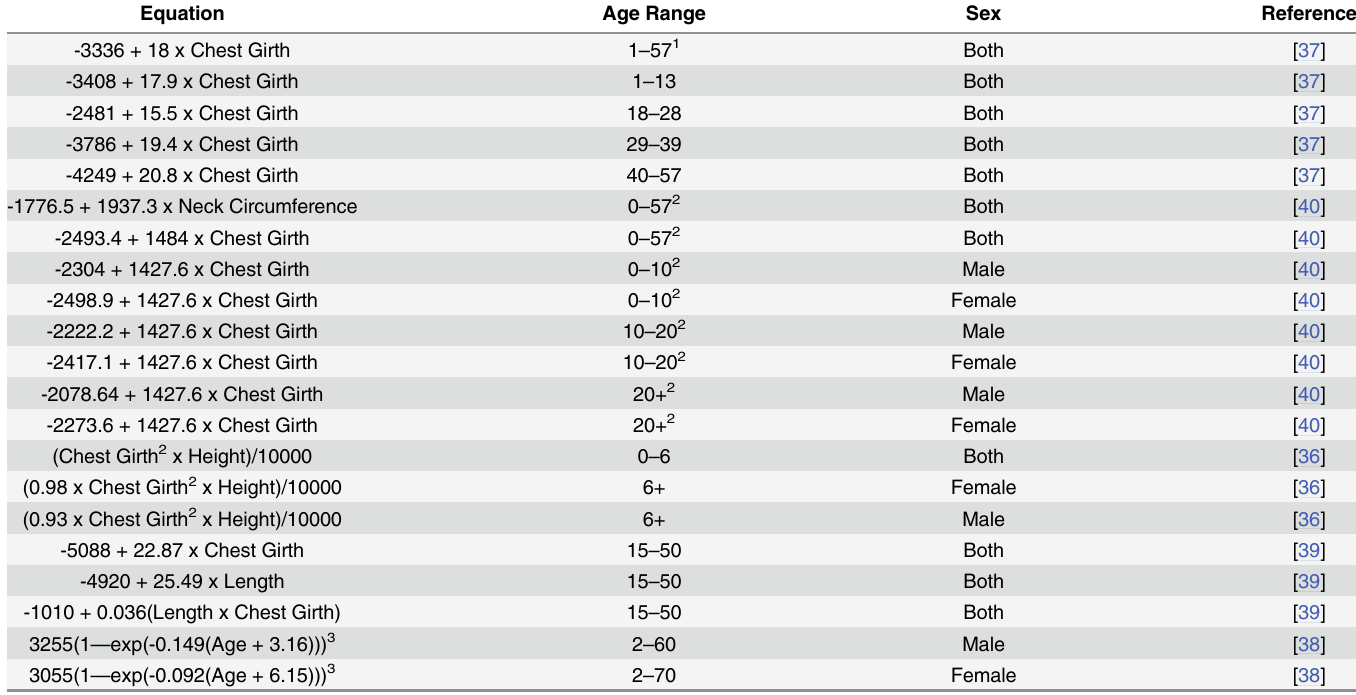
Table 1. Existing equations for predicting elephant weight from the